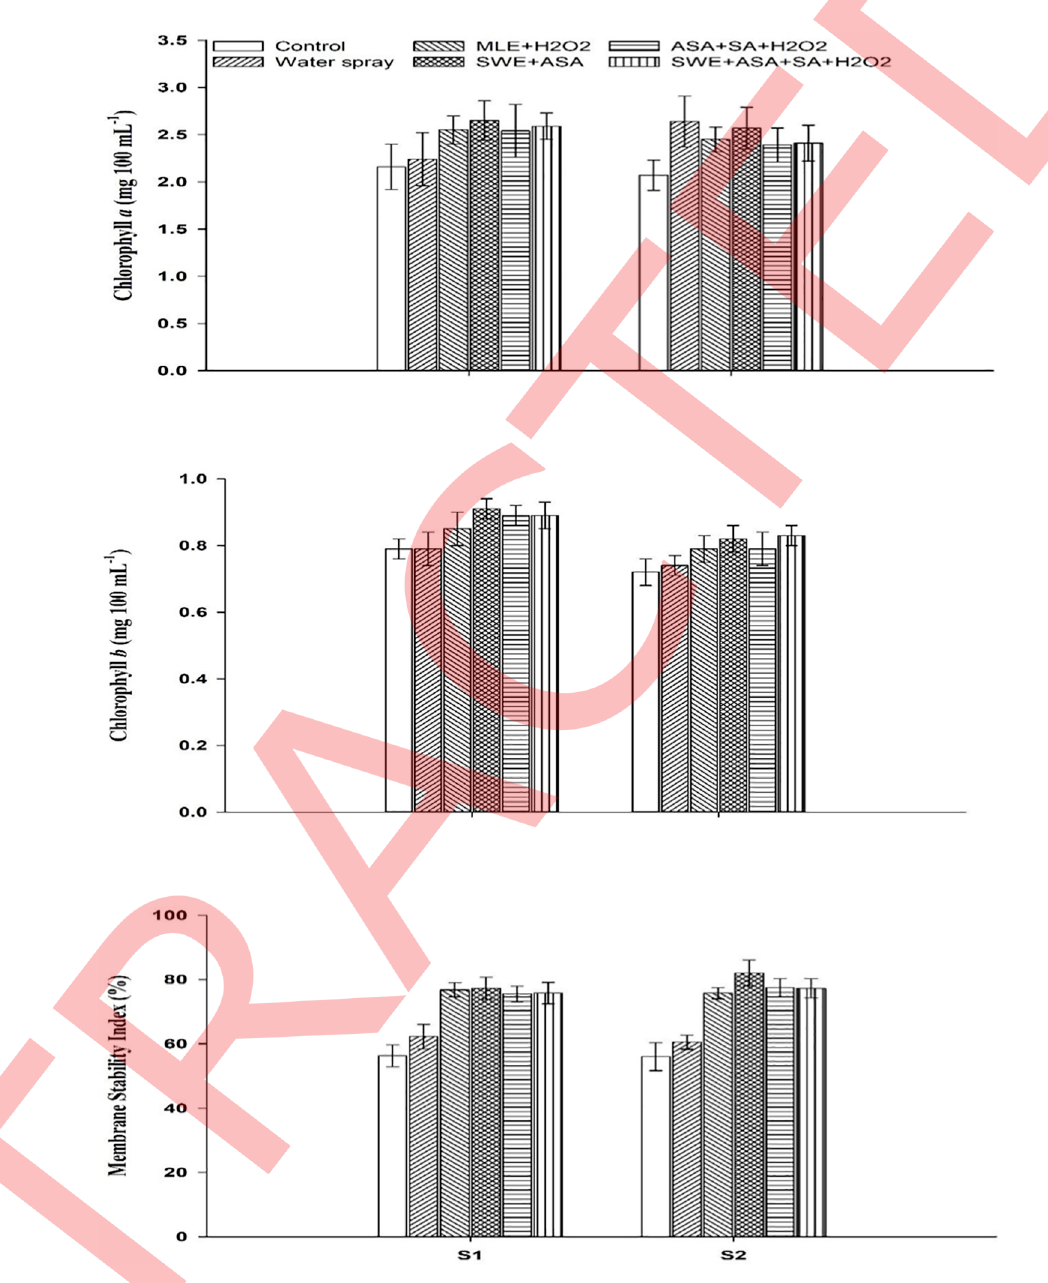
Fig 3. Chlorophyll a, b and membrane stability index of maize influenced by foliar applied growth promoting agents and sowing dates. sowing dates respectively. Whereas parameters (transpiration rate, stomatal conductance, internal CO concentration, biological yield, grain yield and photosynthesis rate) shown in 2 quadrant 4 were significantly T4 (ASA+SA+H O T5 (SWE+ASA+SA+H O ) at S1. In addi- 2 2 2 2 tion, parameters (stomatal conductance, transpiration rate, grain yield, photosynthesis rate, internal CO concentration, biological yield and cobs per plant) were significantly by T4 and 2 T5 at S2. All physiological, yield and related attributes exhibited highest cosine values on F1 axis except grain weight when sown early (S1). Grain weight (early sowing) had highest cosine